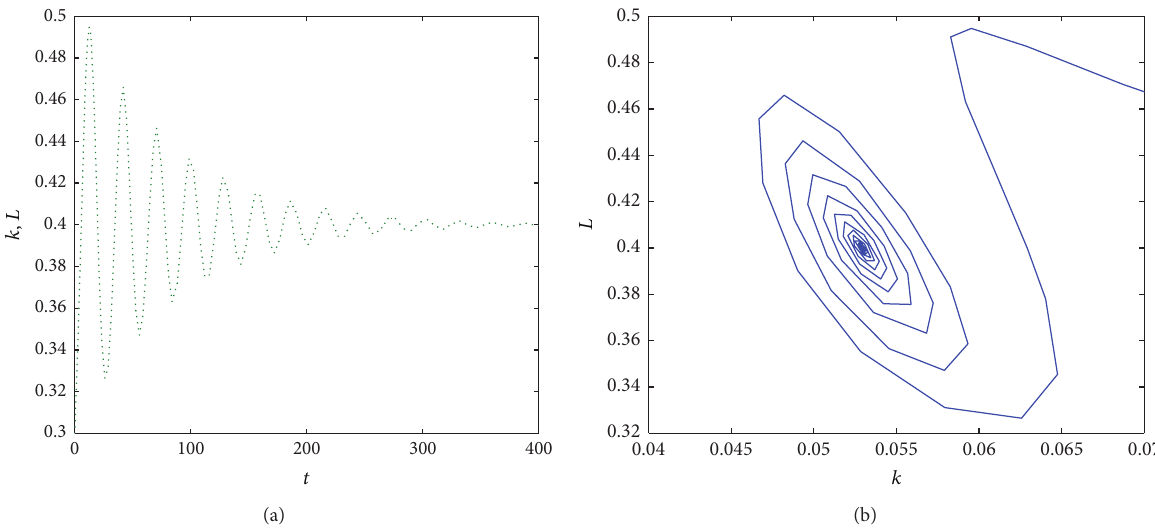
Figure 4: The time evolution of the functions 𝑘(𝑡) (b) for 𝛼 = 0.8 , 𝑠 = 0.5 , 𝑎 = 0.2 , 𝑏 = 0.5 , 𝛿 = 0.9 , and 𝜏 = 7 (a). The phase space of 𝐿(𝑡) versus 𝑘(𝑡) for 𝑡 ∈ [0, 500]